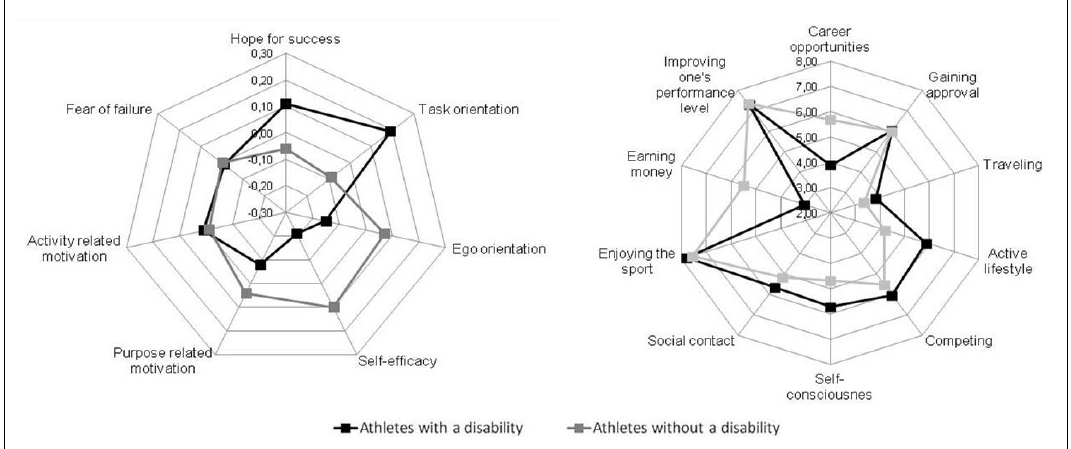
Figure 1. Top: Personal factors in the phase of mastery (z-scores); Bottom: Evaluation of situational incentives in the phase of mastery (1 = unimportant; 10 = very